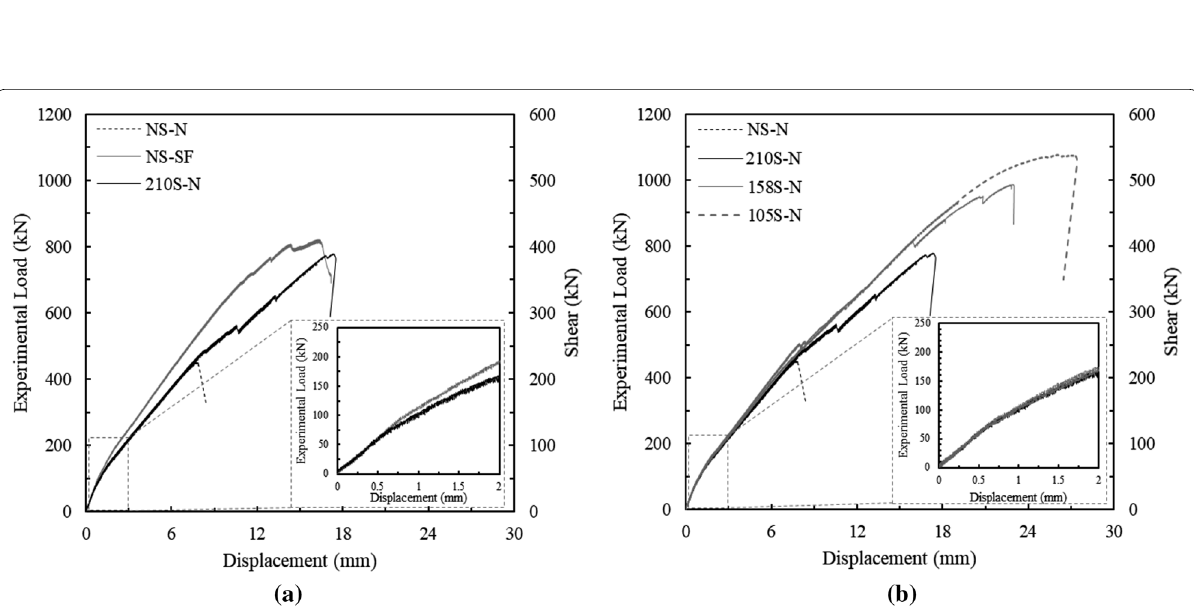
Fig. 6 Experimental shear load–deflection curves; a reinforced by minimum reinforcement, and b reinforced by various space of